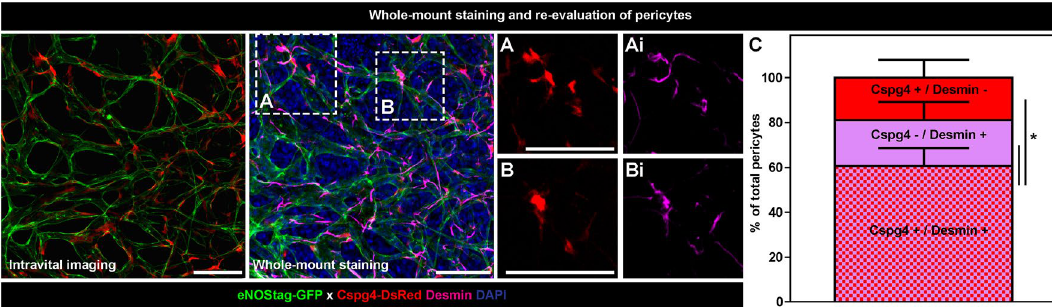
Figure 10. Whole-mount re-evaluation of pericytes. Representative 70 µm maximal projections of the intravital image and whole-mount staining. Endogenous fluorescence of GFP (eNOS, endothelial cells) and ( A , B ) DsRed (Cspg4, pericytes) is still present after PFA fixation and ( Ai , Bi ) pericytes are stained for Desmin (purple) and nucleus with DAPI (blue). Scale bar represent 100 µm. ( C ) Graph representing percentage pericytes